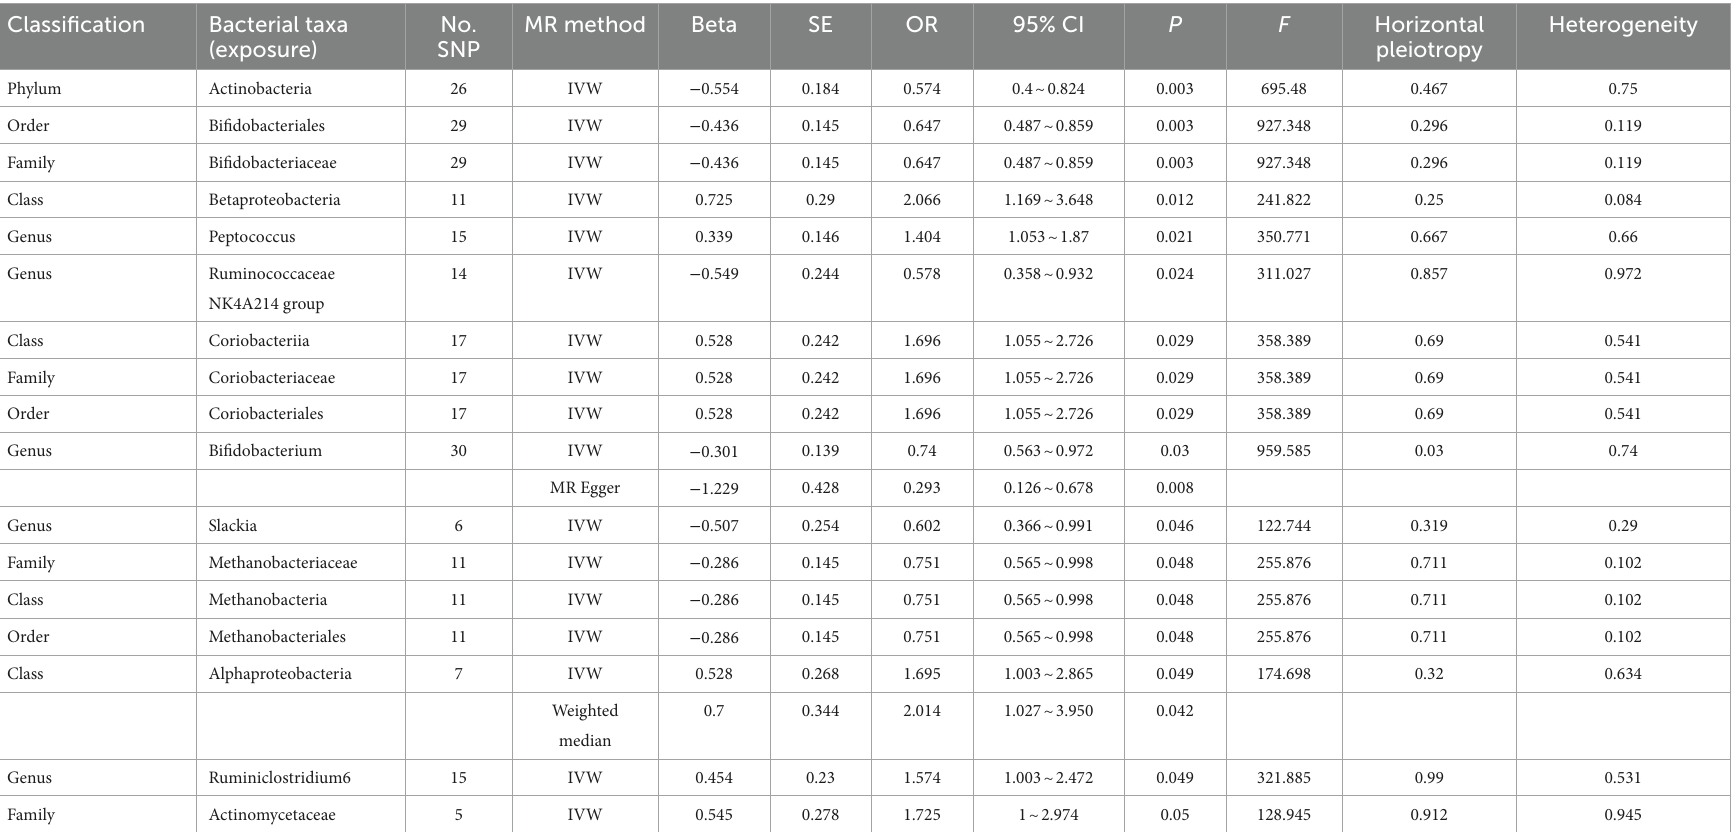
TABLE 2 Mendelian randomization analysis of gut microbiota on ADHD in replication samples (locus-wide significance level, P < 1 × 10 − 5